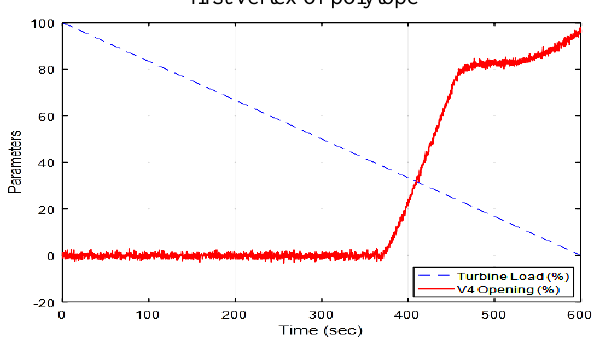
Fig. 13. Steam dump valve-4 actuation with turbine load at first vertex of